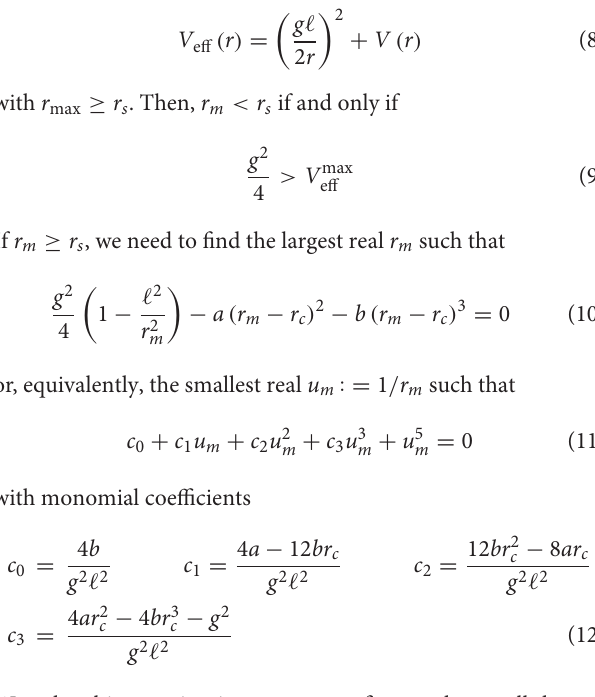
overcome any energy barrier along the way to r